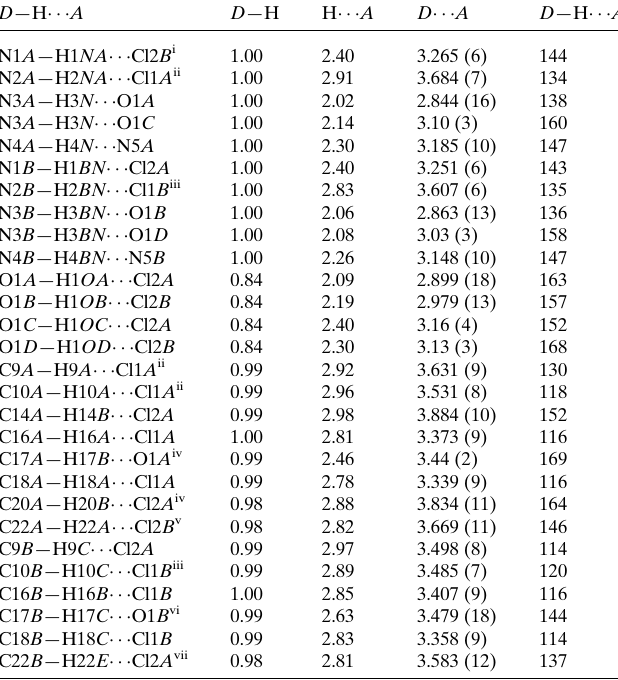
macrocyclic carbon atoms. The type and number of hydrogen bonds is essentially the same between the two halves of the